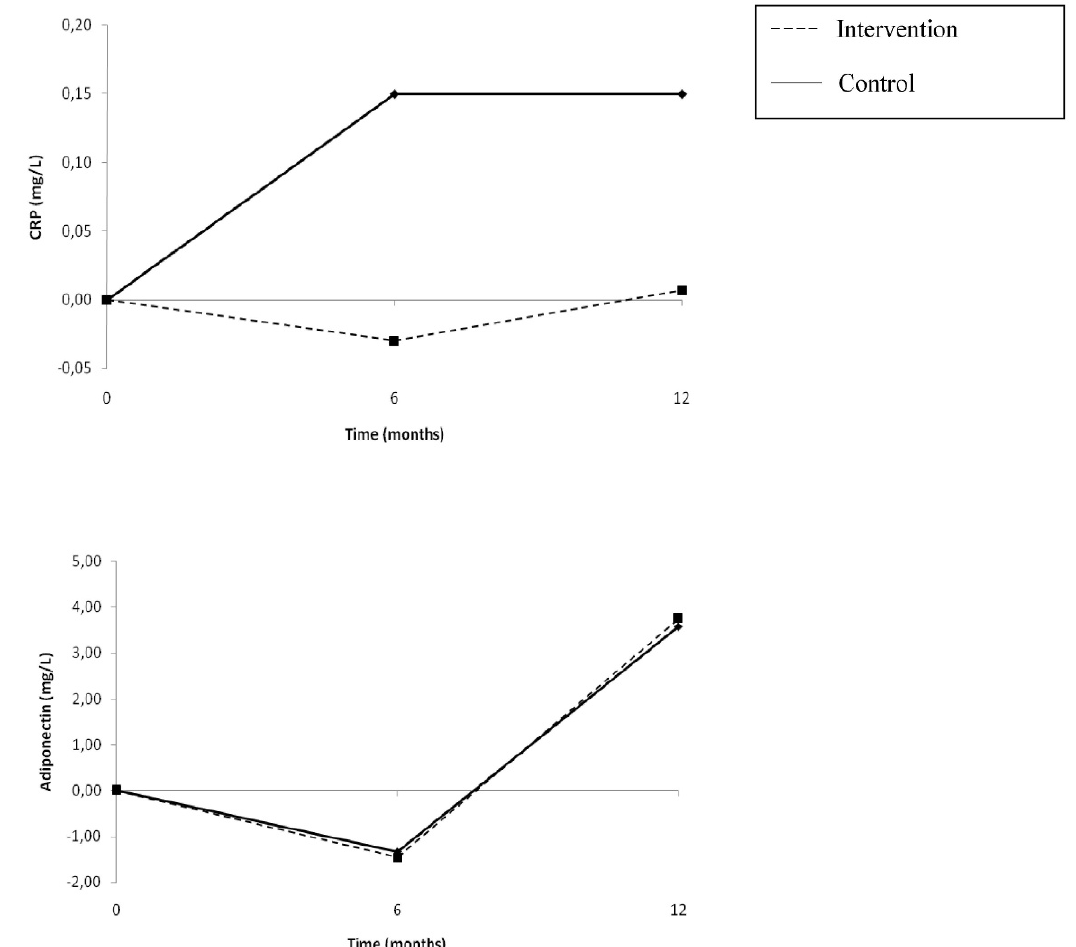
Figure 1 - Estimated changes for CRP and adiponectin during the 12 months of follow-up by